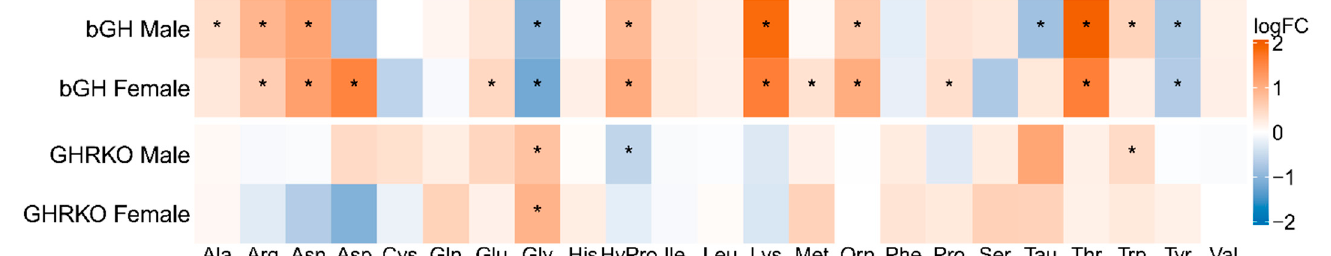
Figure 1. Plasma Amino Acid Levels. The plasma from 7-month-old bGH and GHRKO males and controls were used for amino acid measurements. Data are shown as the log2 fold change in each group compared to its respective control group, with red indicating an increased plasma concentration and blue indicating a decrease compared to wild type. * Indicates t -test p < 0.05 comparing each experimental group to sex-matched WT.